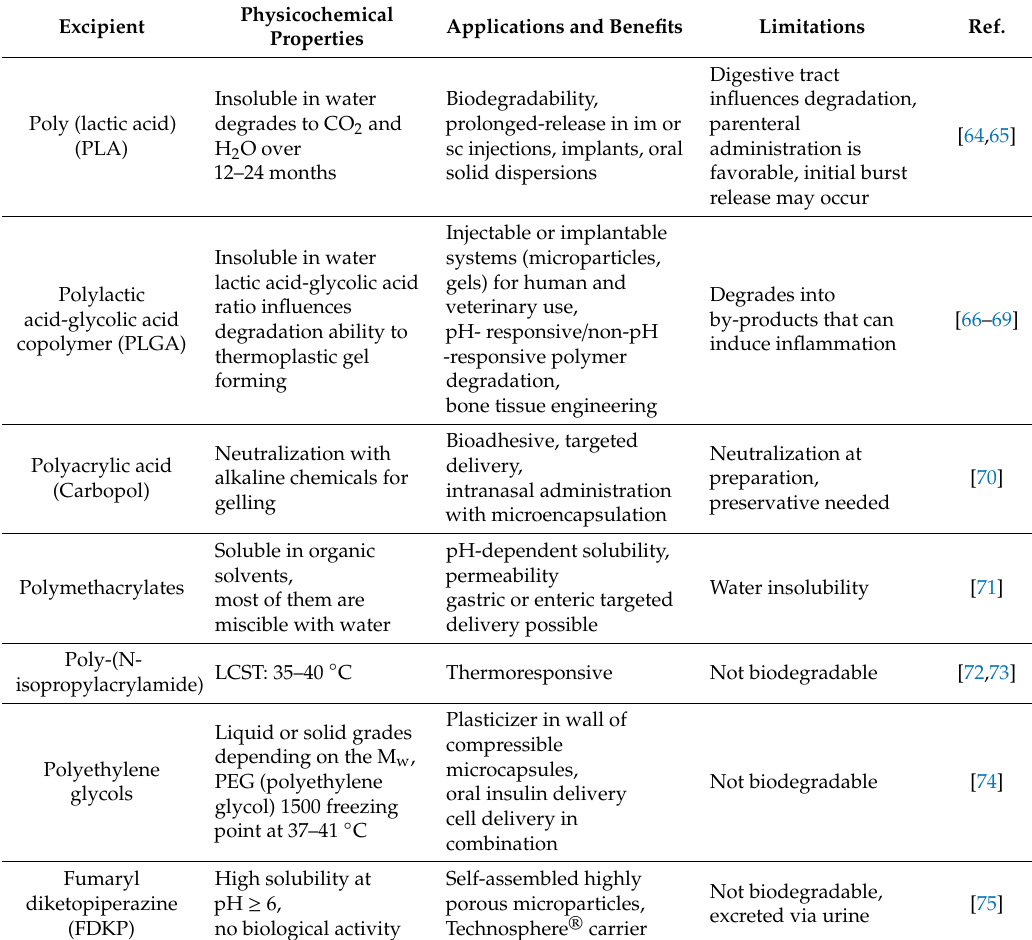
Table 5. Synthetic polymers applied in microencapsulations.